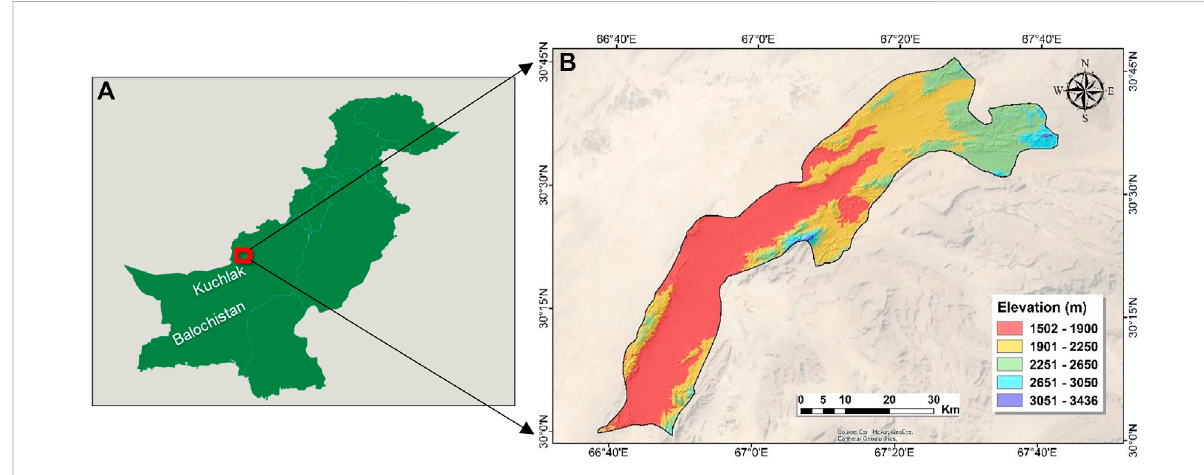
FIGURE 1 Map of Study area (Kuchlak Sub-Basin) showing (A) location, and (B)